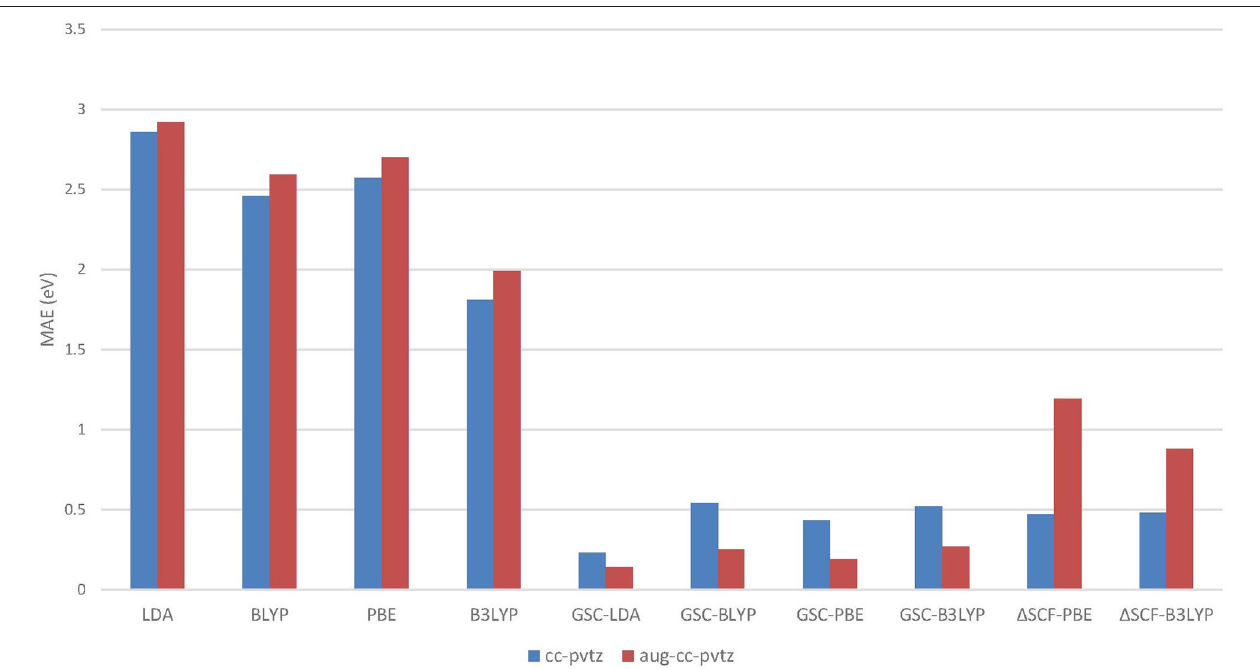
FIGURE 5 | The mean absolute errors (MAEs) of the EAs for an extended set of 64 molecules calculated by employing the QE-DFT method with various density functional approximations (DFAs) and by using the 1 SCF method. Note that when the more diffuse aug-cc-pVTZ basis set is adopted, the energy of a certain virtual Kohn–Sham (KS)/generalized KS (GKS) orbital should be taken as the predicted EA; see Table 2 for details. If the orbital relaxation is considered up to the first order for the GSC-B3LYP, the MAEs become 0.21 and 0.28eV with the cc-pVTZ and aug-cc-pVTZ basis sets, respectively.